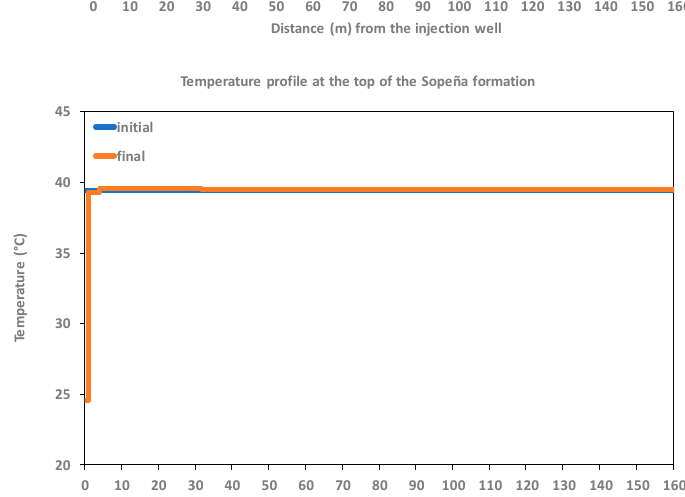
Figure 15. The multiphase flow parameters evolution around the injection well at the end of history matching. The evolution of the pressure ( top ), temperature ( middle ) and CO 2 saturation ( bottom ) as a function of the distance from the well axis at the top of the Sopeña Formation (reservoir) and at the initial (blue) and final (orange) periods of the CO 2 and brine injection.